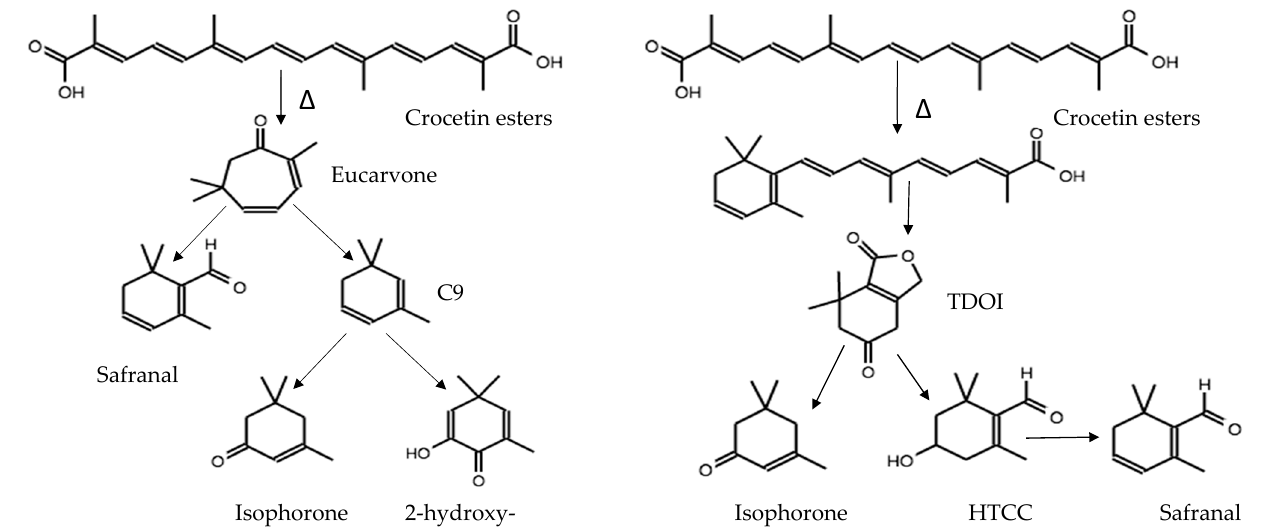
Figure 4. Saffron volatile compounds generation from crocetins esters by thermal degradation.